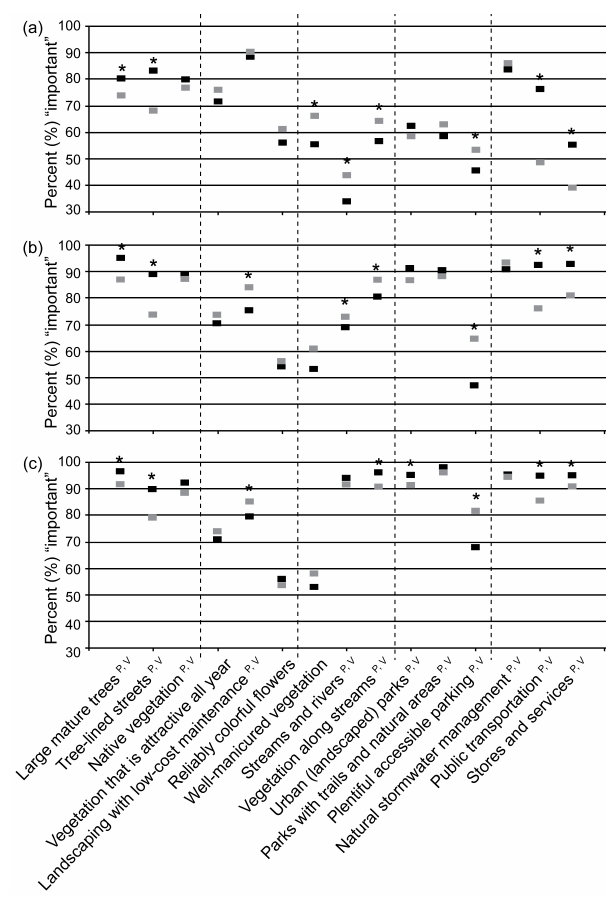
Fig. 1 . Frequency of respondents who indicated importance of 15 landscape characteristics at the (a) property-level (at or next to my house), (b) neighborhood (within a 20-minute walk from my house), and (c) metro-level (across the metro area) scales. Portland responses are indicated by black squares; Vancouver responses are indicated by gray squares. An asterisk (*) indicates significant differences between the two cities for each characteristic at each scale. Significant differences across scales for each characteristic and for each city are indicated by P (Portland) and V